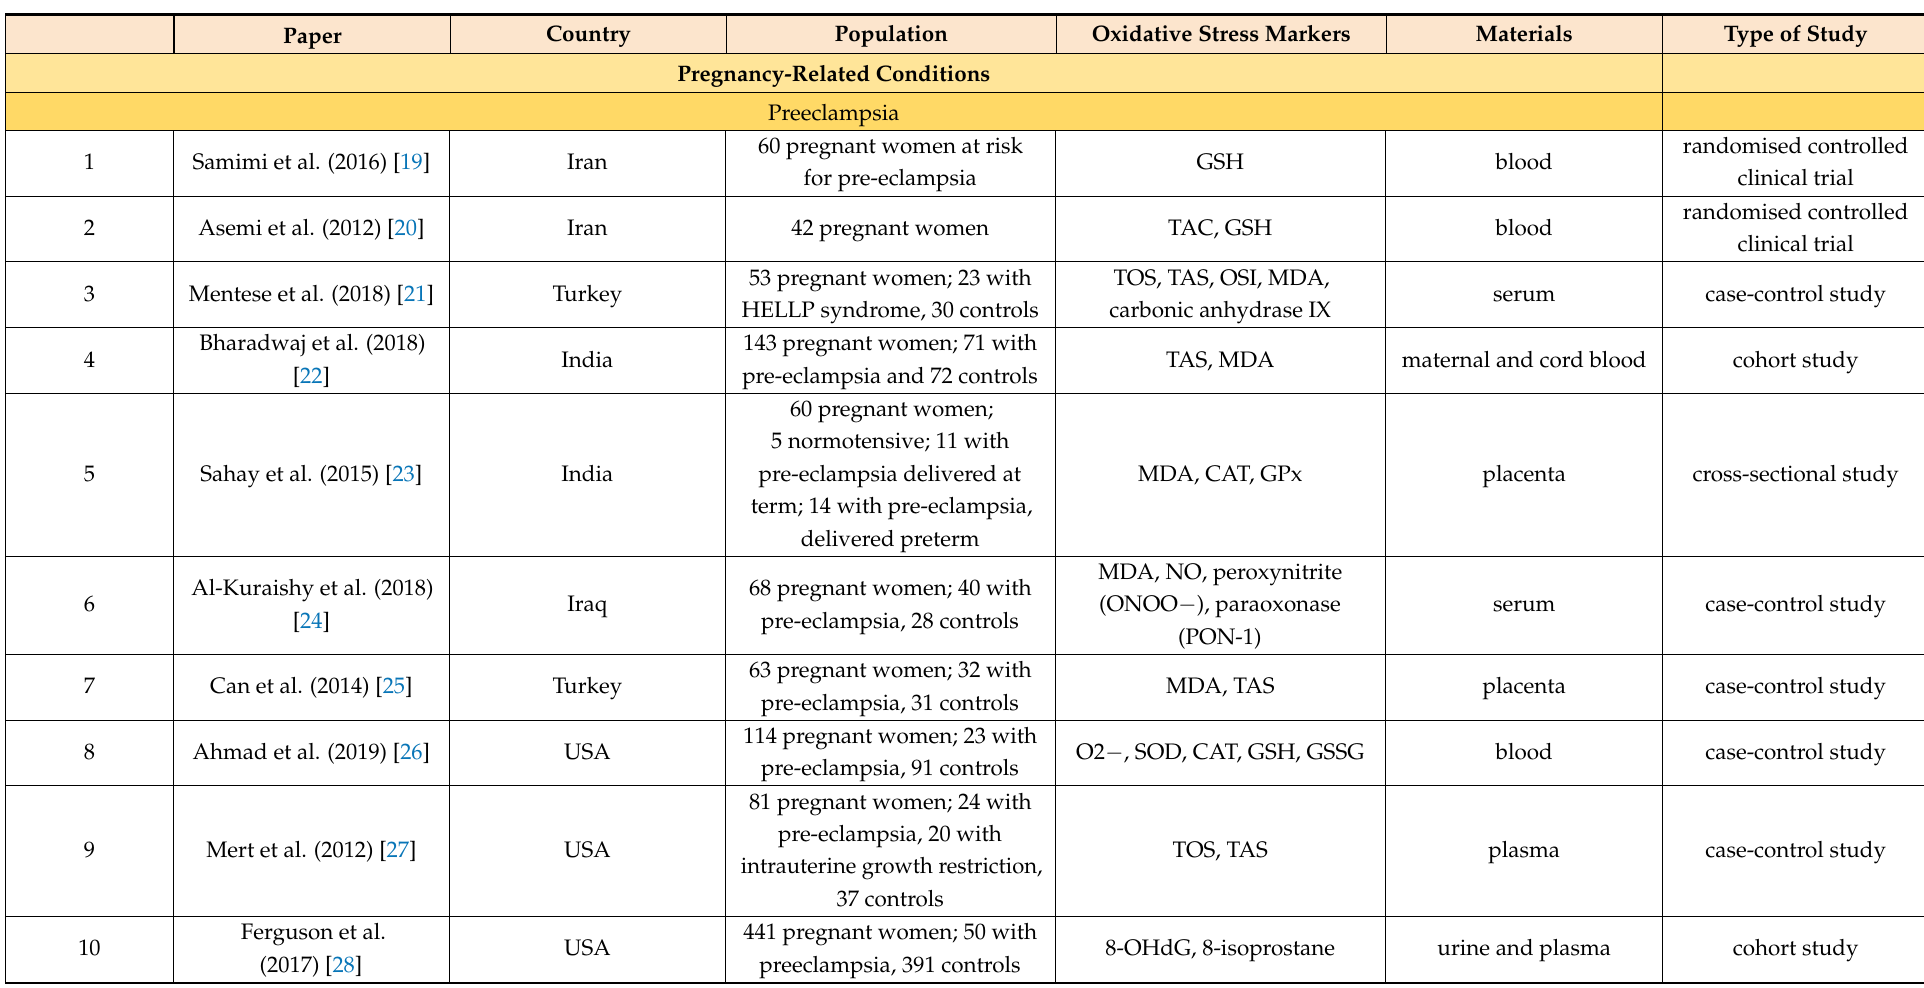
Table A1. Characteristics of the